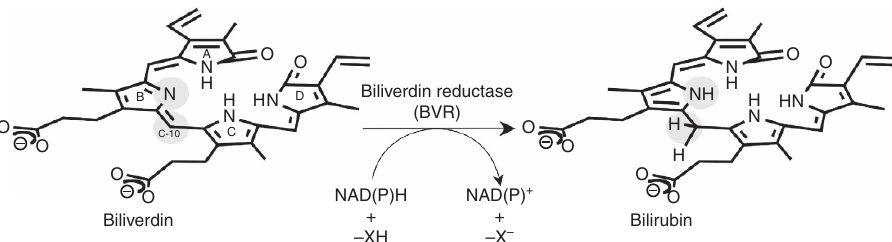
Figure 1 | Reaction catalysed by BVR. The C10 double bond ( g -methene bridge) in BV is reduced by hydride from the cofactor, and the pyrrole nitrogen of the ring is protonated (hydride and proton are depicted on grey circular backgrounds on the product,